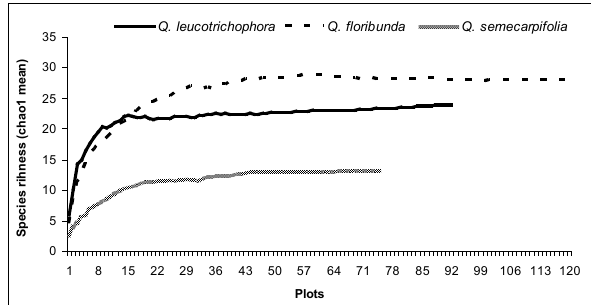
Fig. 2. Rarefaction graph of species richness across various oak